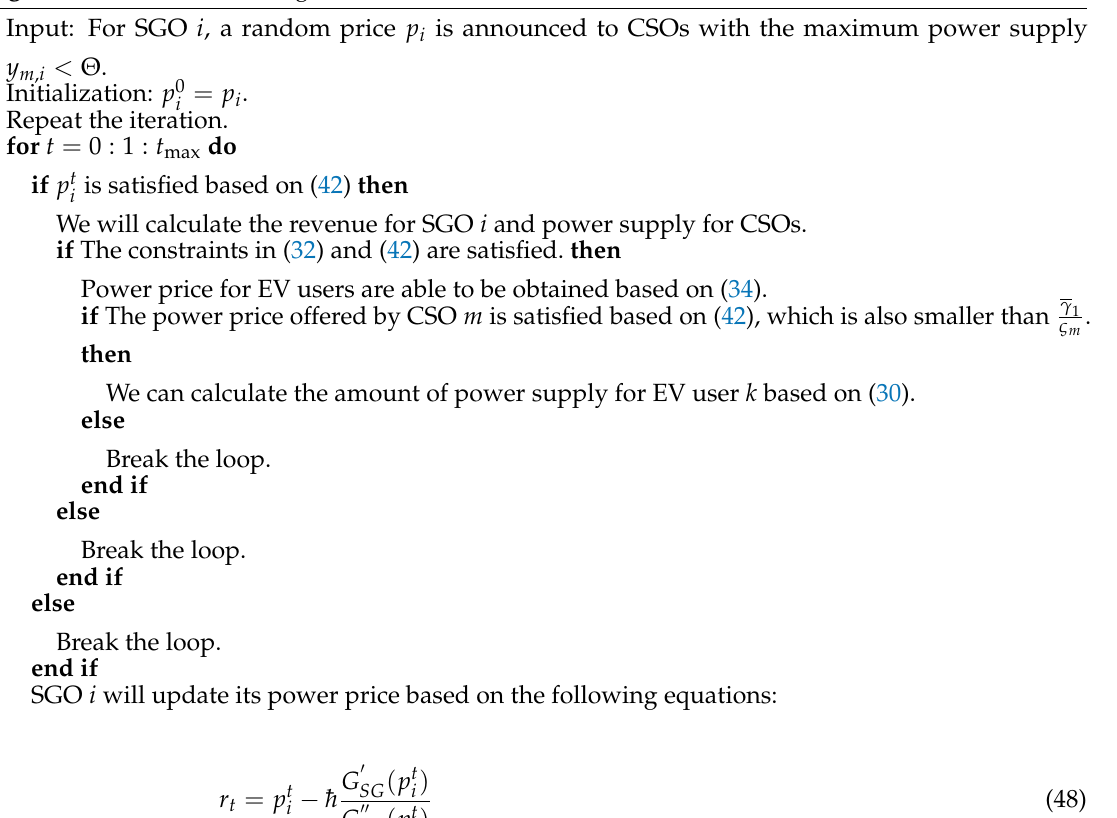
Algorithm 1 : An iterative algorithm for